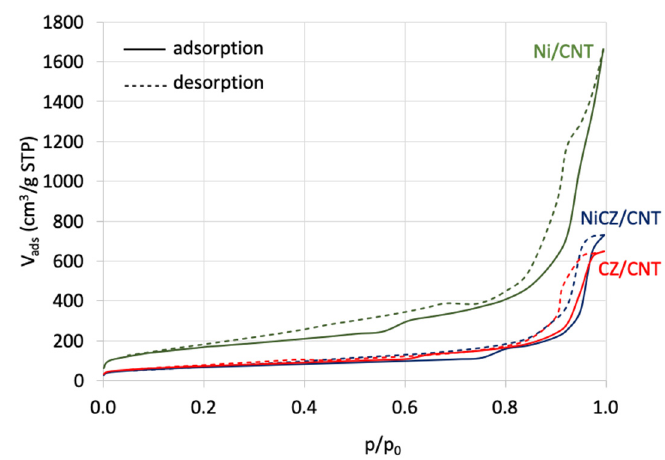
Figure 6. The N 2 adsorption / desorption isotherms for CZ / CNT, NiCZ / CNT and Ni / CNT catalysts.